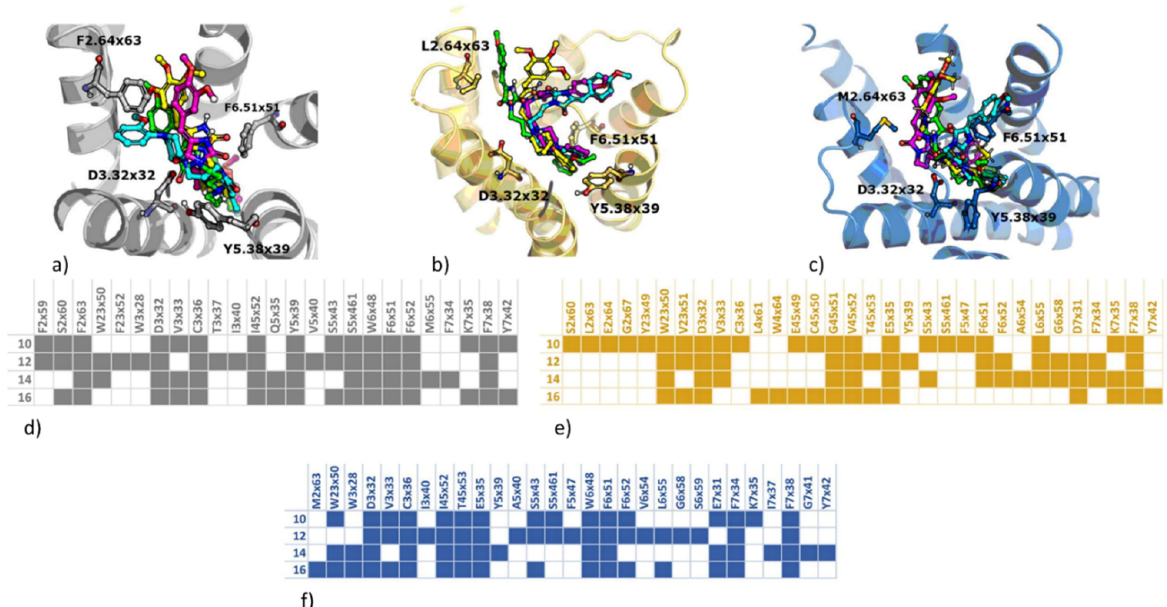
Figure 5. Docking results of compounds 10 (green), 12 (cyan), 14 (magenta), and 16 (yellow) to, ( a ) α 1A R (docking poses), ( b ) α 1B R (docking poses), ( c ) α 1D R (docking poses), ( d ) interaction matrix with α 1A R, ( e ) interaction matrix with α 1B R, ( f ) interaction matrix with α 1D R.